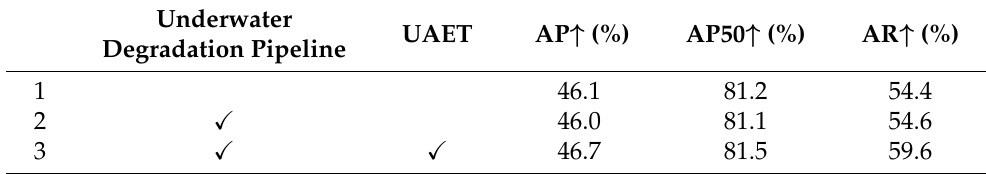
Table 4. The ablation results of the proposed SPJF